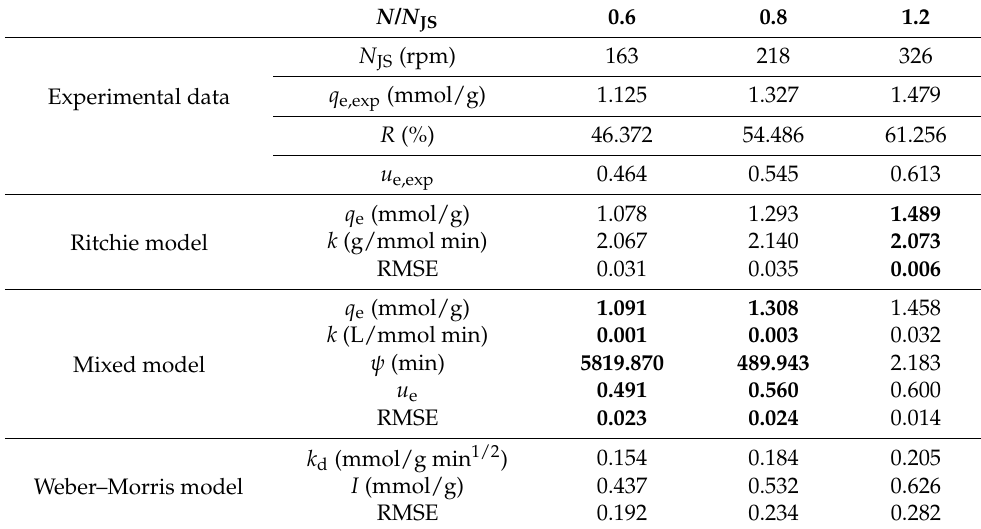
Table 3. Estimated kinetic model parameters and statistical indicators of agreement of all the models used with the experimental data for various impeller speed and zeolite mass of 10.50